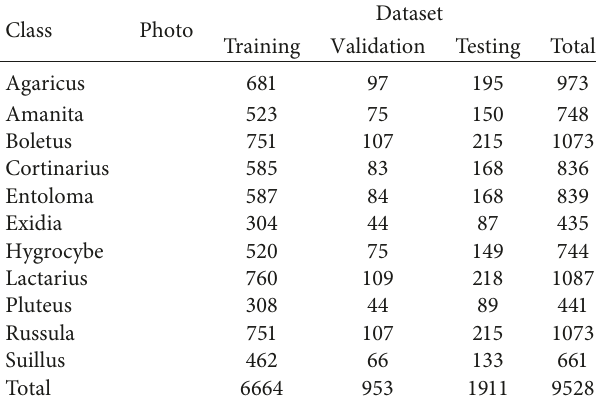
Table 1: Training, validation, and test sets for the mushroom classification